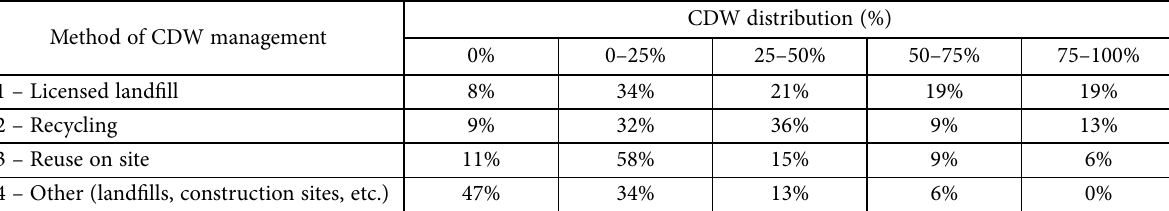
Table 5. Method of CDW management ( n = 153)